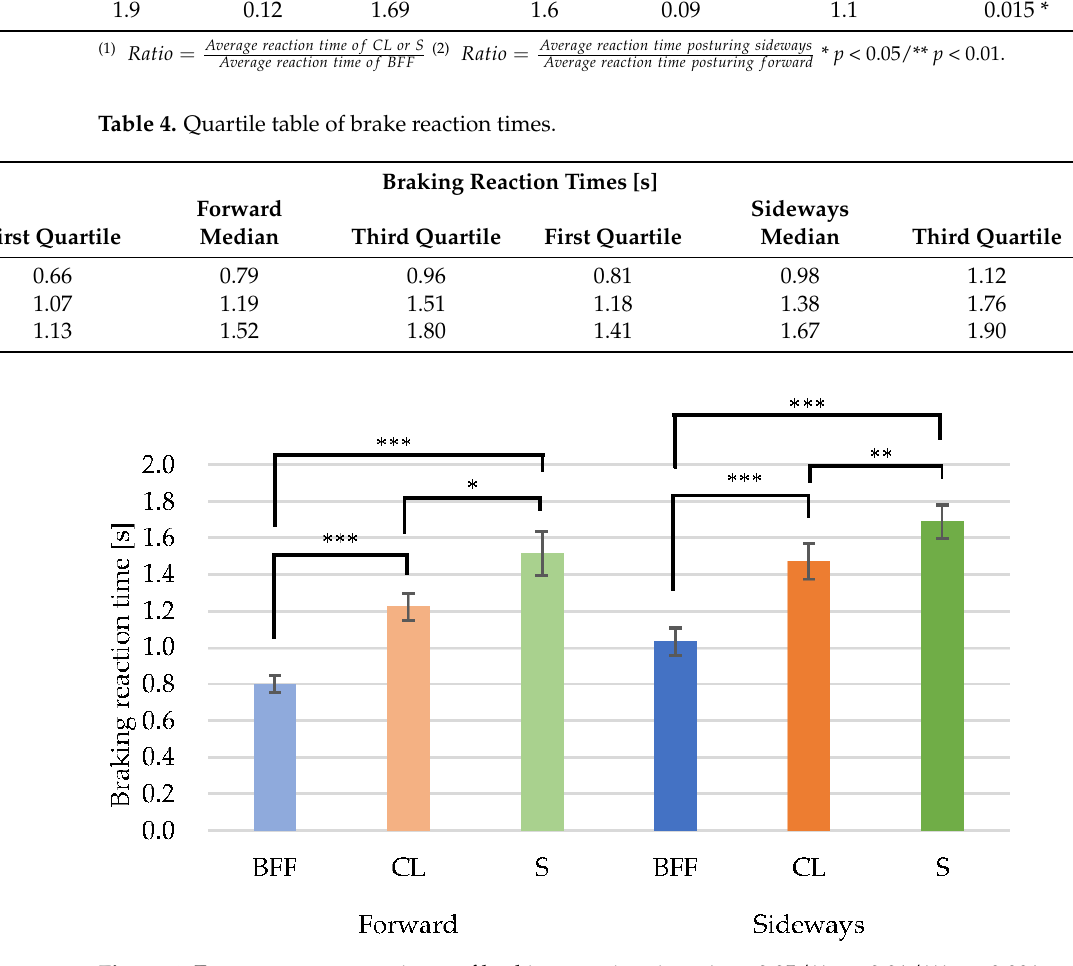
Table 3. Braking reaction times.